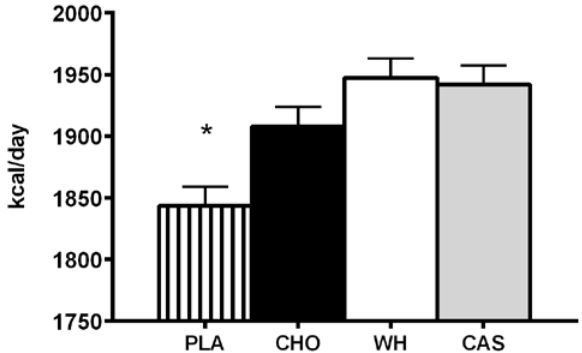
Figure 2 . Resting Energy Expenditure Following Nighttime Macronutrient Ingestion in Young Active Men. PLA, placebo; CHO, carbohydrate; WH, whey protein; CAS, casein protein. This figure was adapted and redrawn from Madzima et al. [47]. * indicates significant difference from CHO, WH, and